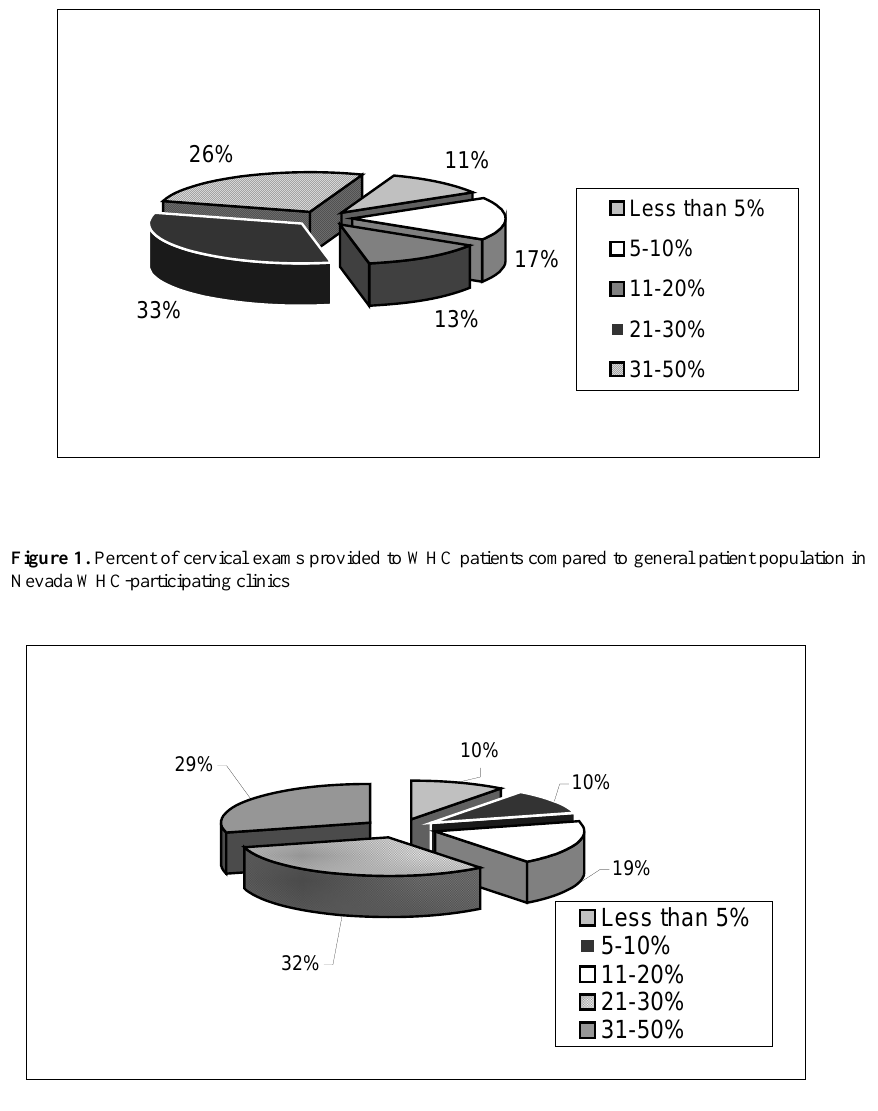
Figure 2. Percent of clinical breast exams provided to WHC patients compared to general patient population in Nevada WHC-participating